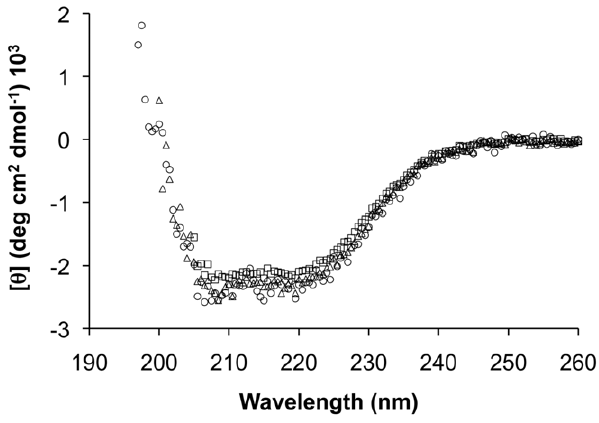
Figure 3. Circular dichroism spectra of recombinant human PLUNC. Circular dichroism spectra of recombinant human PLUNC. Molar ellipticities in the far-UV range (197–260 nm) are plotted for PLUNC at 0.54 mg/mL (circles), 1.08 mg/mL (triangles), and 2.16 mg/mL (boxes). Analysis of this data using the K2d server predicts that the secondary structure of PLUNC is 24-33% alpha-helical, , 15% beta-sheet and 51–61% random coil.